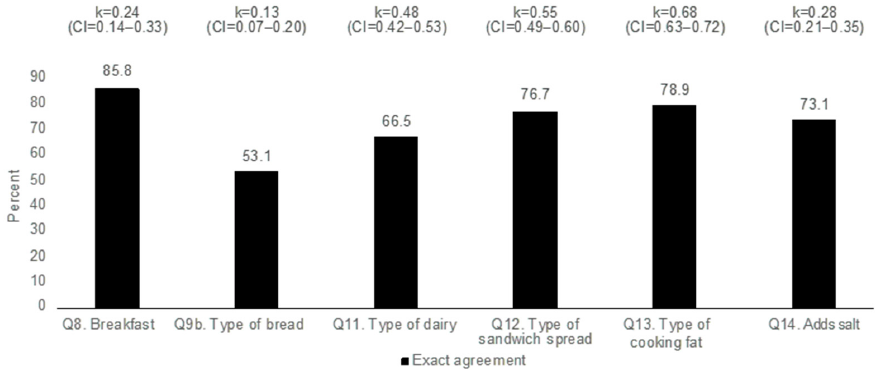
Figure 1. Proportion of agreement between methods for frequency items in the Food Frequency Questionnaire compared with Diet History, and respective weighted kappa values.